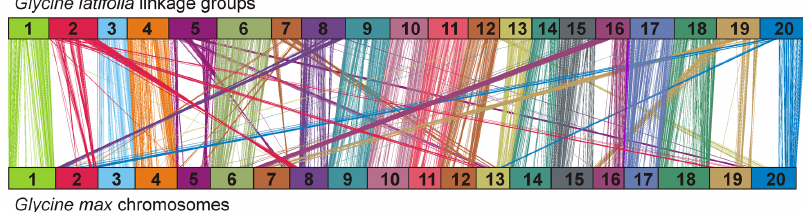
Figure 2. Synteny between Glycinelatifolia linkage groups and G.max chromosomes. Sequences containing mapped G. latifolia SNPs were aligned to the G. max genome sequence. Glycine latifolia linkage groups (top) and physical maps for each G. max chromosome (bottom) are displayed as linear arrays. Vertical and diagonal lines connect genetic and physical locations of SNP markers between the two species.